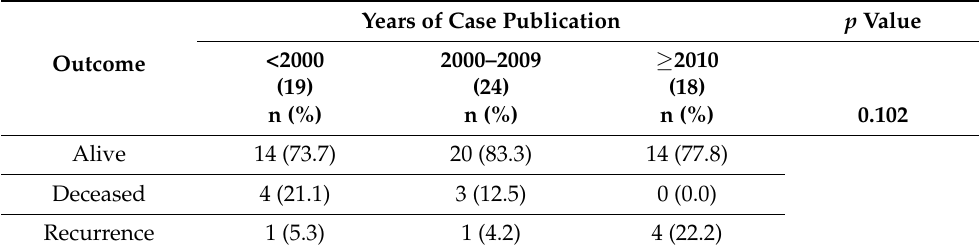
Table 6. Patients’ outcome according to the years of case